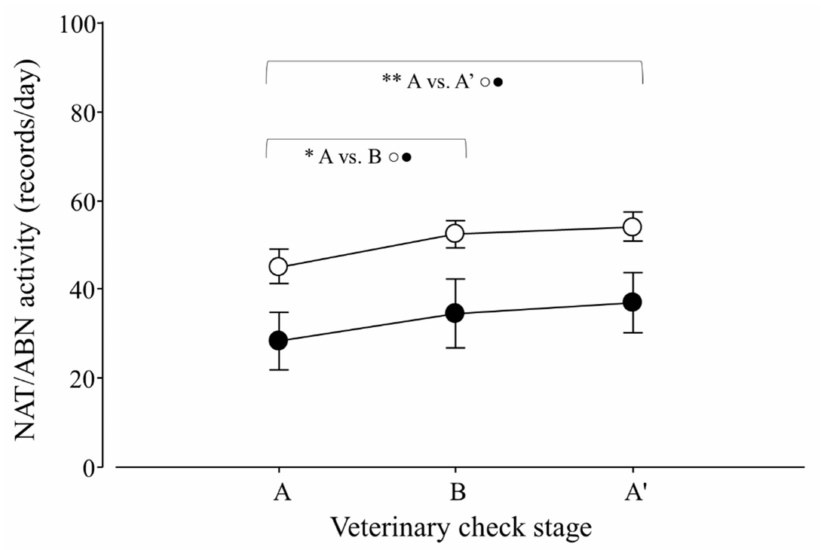
Figure 5. Natural (NAT; ) and abnormal activity (ABN; • ) per day of adult Tamandua tetradactyla (cid:35) ( n = 3 females and 3 males) exposed to semi-controlled conditions, in response to veterinary check (applied in B) during winter and summer. Data from winter and summer were pooled, because there was no effect of season. The ABA experimental design applied: day 0 (previous-stage A), days 1 and 2 (disturbance—stage B) and day 3 (posterior-stage A (cid:48) ). Behaviour was recorded every 5 min (288 records/day/individual), and the number of activity records per day during each stage per season was calculated. Asterisks indicate significant differences between stages for all individuals ( p values in the text). Results are expressed as the mean ± SEM. Table 2. Effect of seasonal veterinary check on activity cycle of adult Tamandua tetradactyla maintained in semi-controlled